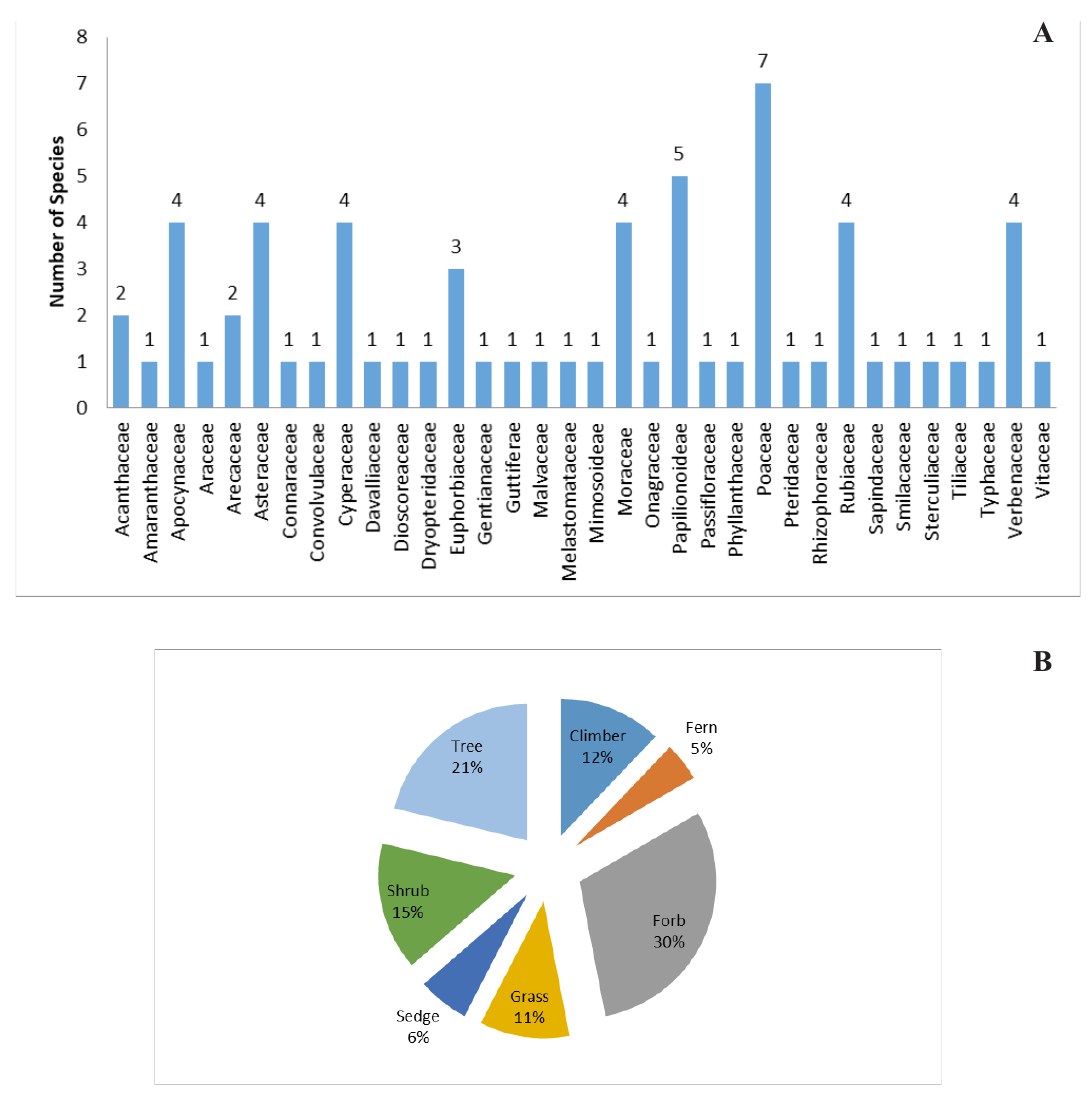
Figure 5. Distribution of species in Ikorodu, Lagos state, Nigeria. A: Family distribution; B: Percentage distribution of Plant life-forms